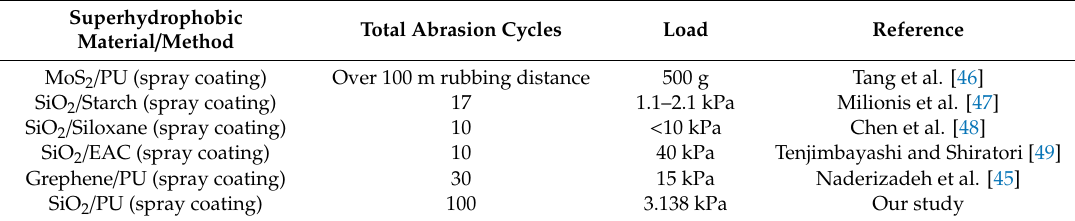
Table 1. Comparison of abrasion wears resistance with the previous reports on the superhydrophobic surface based on spray coating of composited